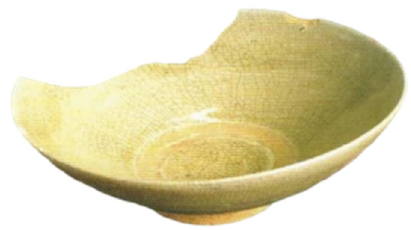
Figure 3. Sample of blue and white porcelain glaze unearthed from Xiaopi kiln